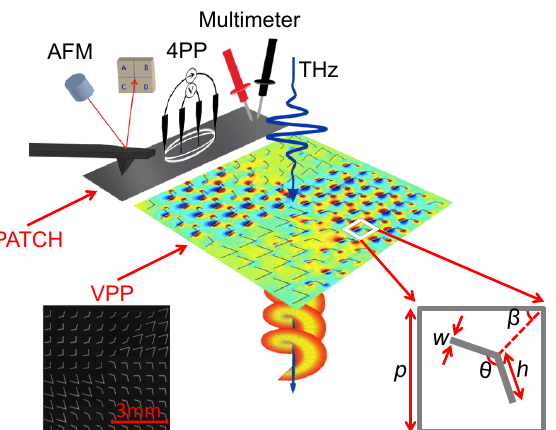
Figure 1. Sketch depicting the provided measurements: atomic force microscopy (AFM), four-point probe (4PP), multimeter, terahertz time-domain spectroscopy (THz-TDS). The left inset is the visible image of the center part of a printed vortex phase plate (VPP). The right inset shows one representative V-shaped antenna unit with the geometrical parameters. Dimensions of p = 600 µ m, w = 30 µ m, β = 45 ◦ were kept the same for all antennas. The length of the slit h = 234, 246, 270, 450 µ m and the angle between slits θ = 130 ◦ , 120 ◦ , 100 ◦ , 60 ◦ according to order of antennas in